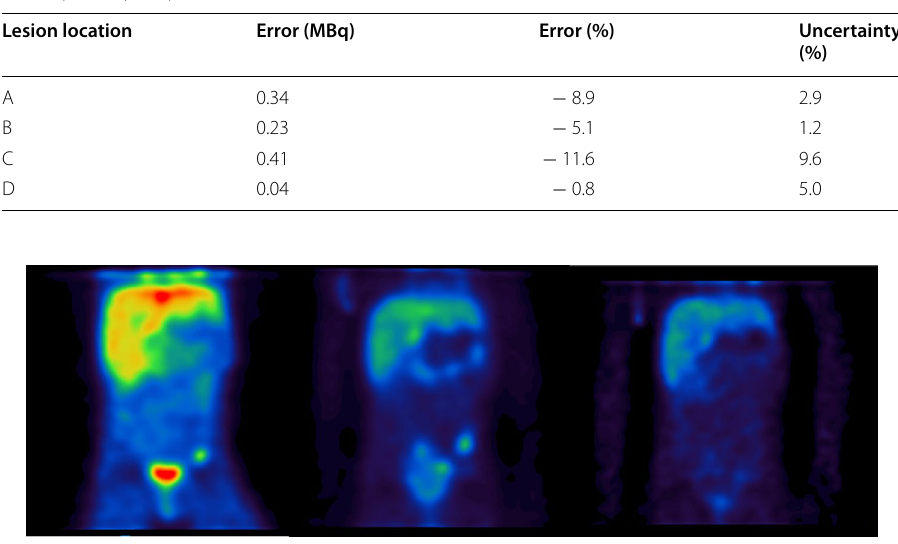
Fig. 10 Coronal view of SPECT images at ~ 2 days, 5 days and 10 days. Quantification was performed on the bone metastases visualised in the left pelvic bone